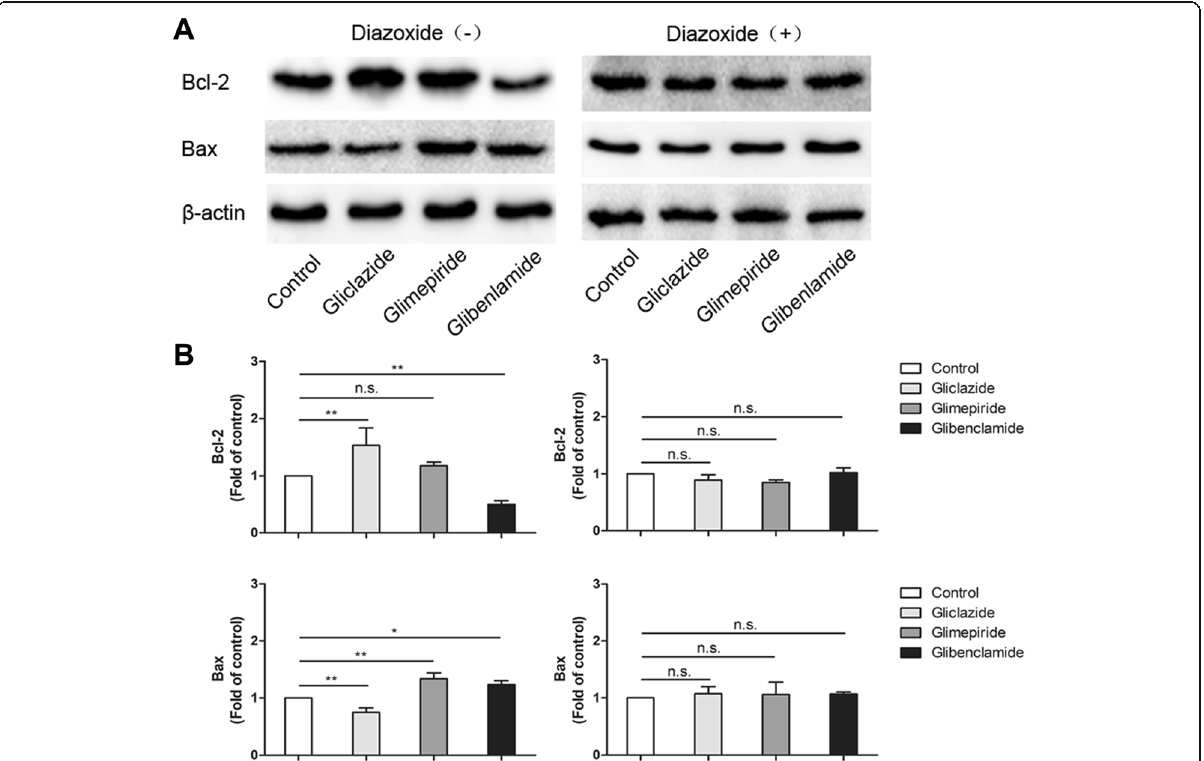
Fig. 2 Bcl-2 and Bax expression in SUs and SUs + DZ groups. a Representative image of Western Blot of cells extracts. b Quantificaton of Western Blot results. Mean ± SD of three independent experiments * P < 0.05 versus control, ** p < 0.01, n.s. not